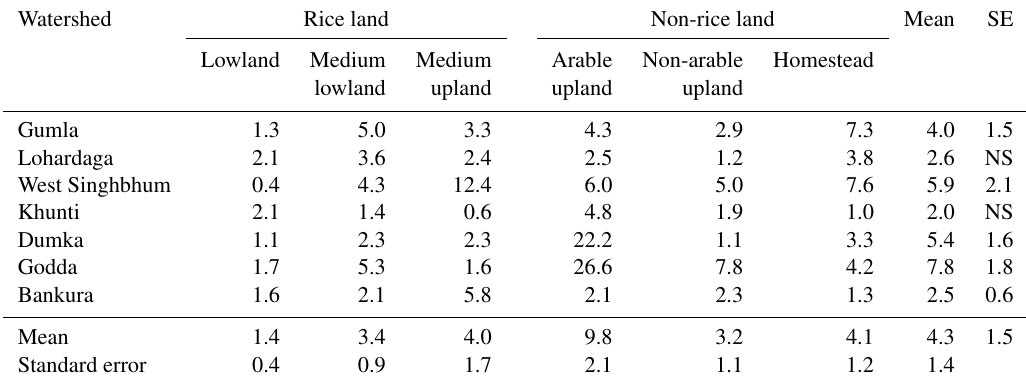
Mean Standard error